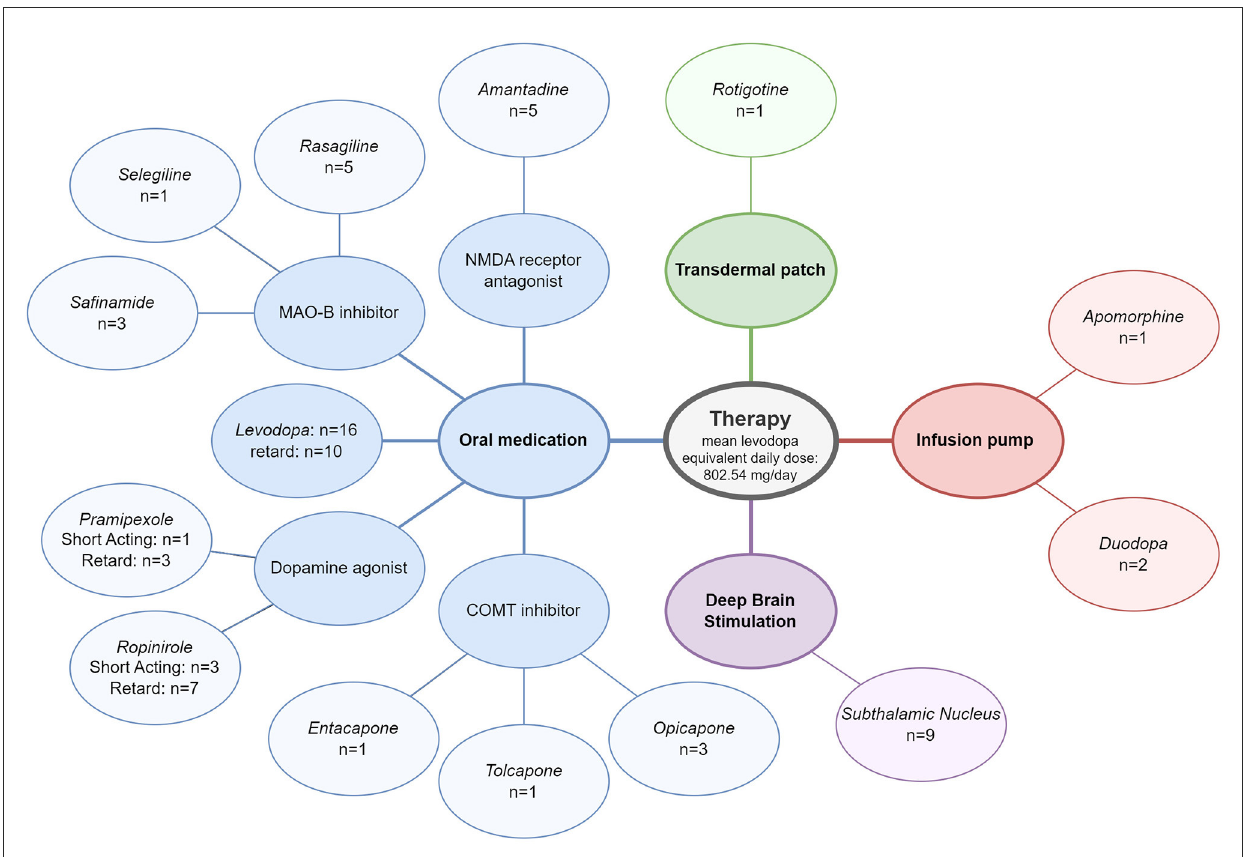
FIGURE2 Therapy of patients with Parkinson’s disease included in phase